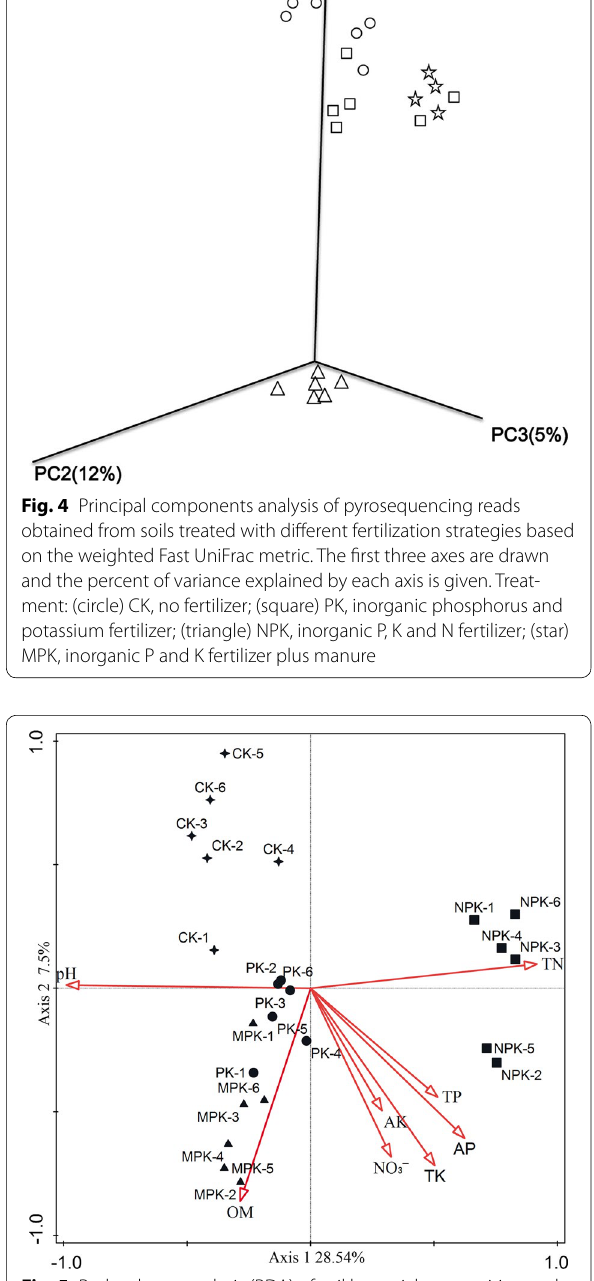
Fig. 5 Redundancy analysis (RDA) of soil bacterial composition and soil properties. Soil factors indicated in arrows include Avail P (avail- able phosphorus), Avail K (available potassium), pH, NO3– (nitrate nitrogen), TN (total nitrogen), TK (total potassium), TP (total phospho- rus) and OM (organic matter). Treatment: (star) CK, no fertilizer; (circle) PK, inorganic phosphorus and potassium fertilizer; (square) NPK, inorganic P, K and nitrogen fertilizer; (triangle) MPK, inorganic P and